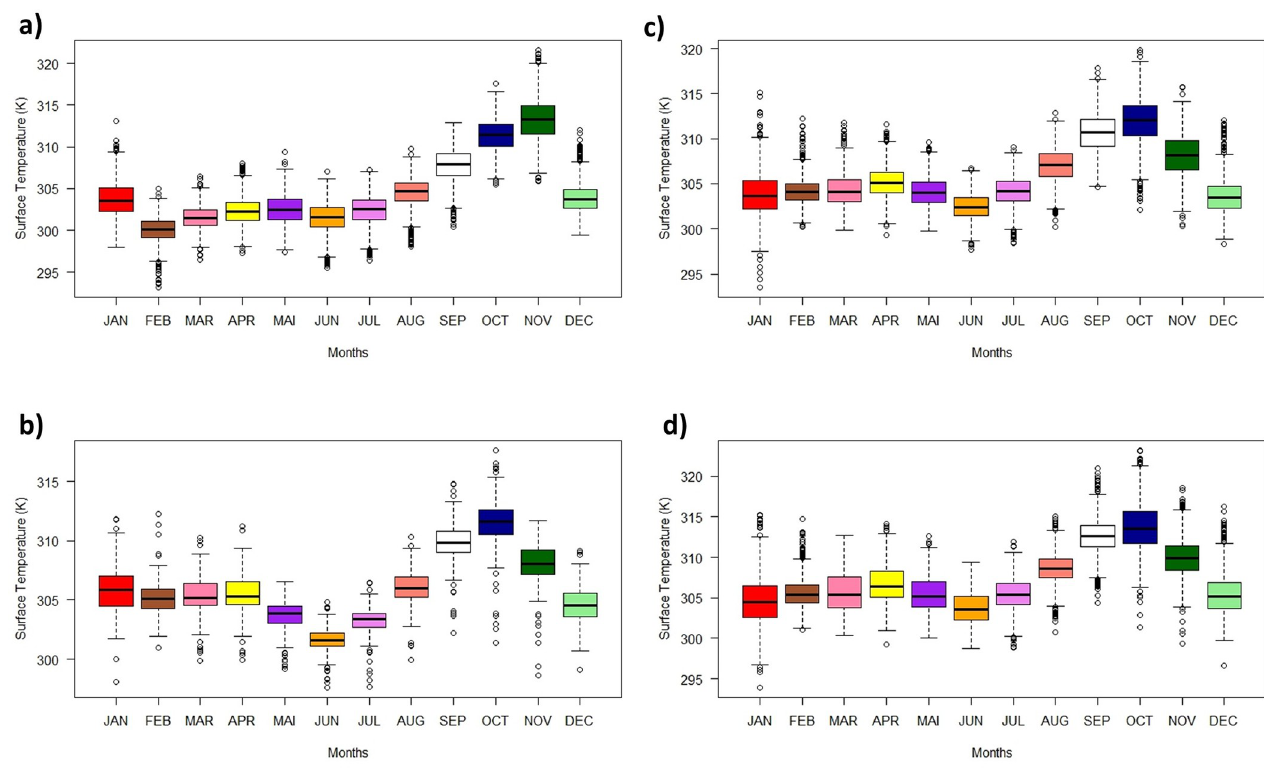
Fig 5. Monthly surface temperature boxplot (January to December) for land uses and land cover in the study area. a) monthly ST for the TDFs in 2007; b) monthly ST for the TDFs in 2016; c) monthly ST for pastureland in 2016; d) Monthly ST for crop in 2016.